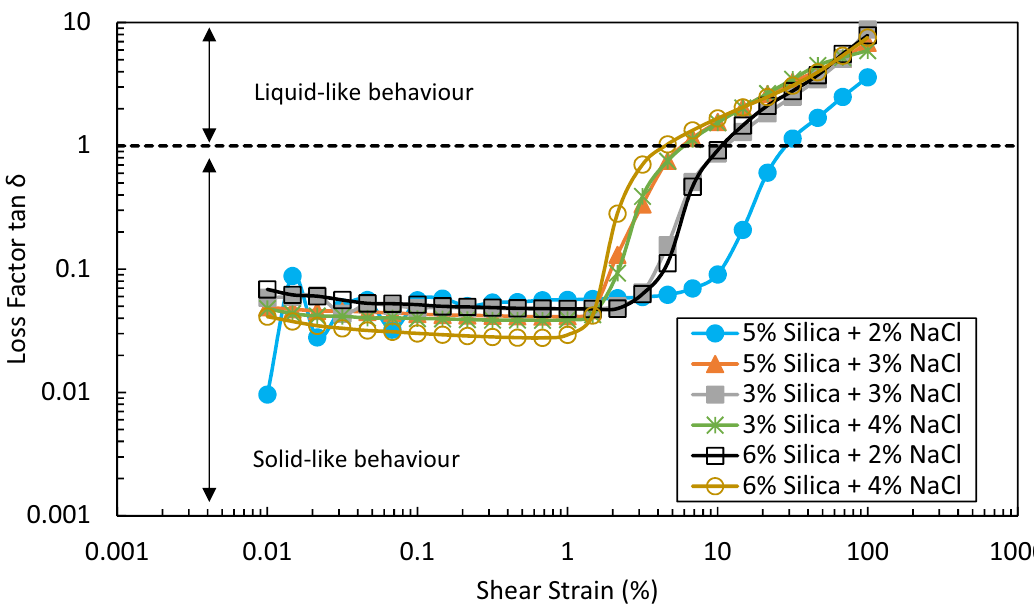
Figure 12. Loss factor (G ″ /G ′ ) versus shear strain for solid gels formed from different concentrations of silica and NaCl in DIW after 24